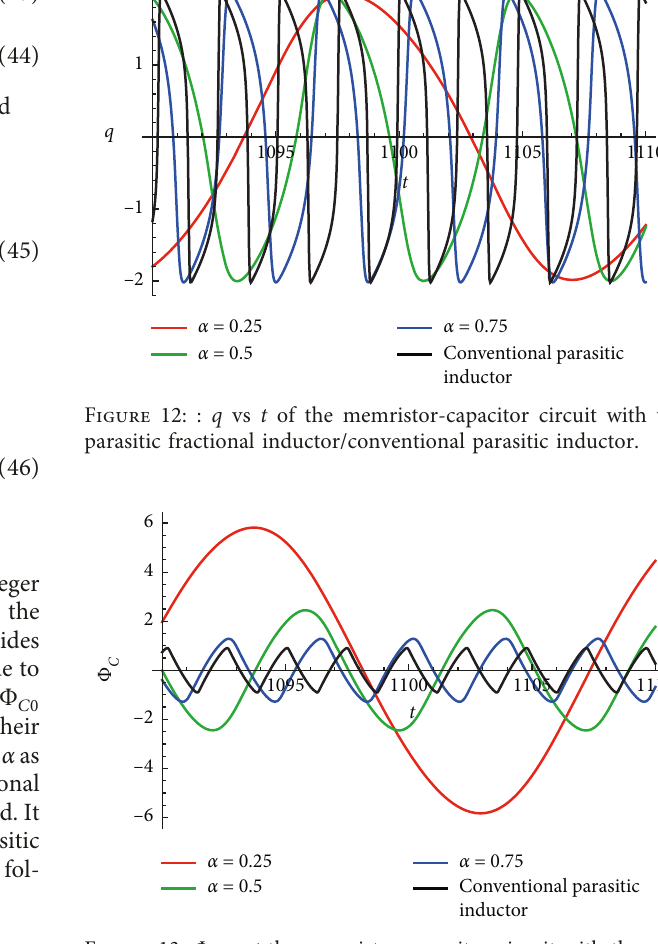
Figure 13: Φ C vs t the memristor-capacitor circuit with the par- asitic fractional inductor/conventional parasitic inductor.